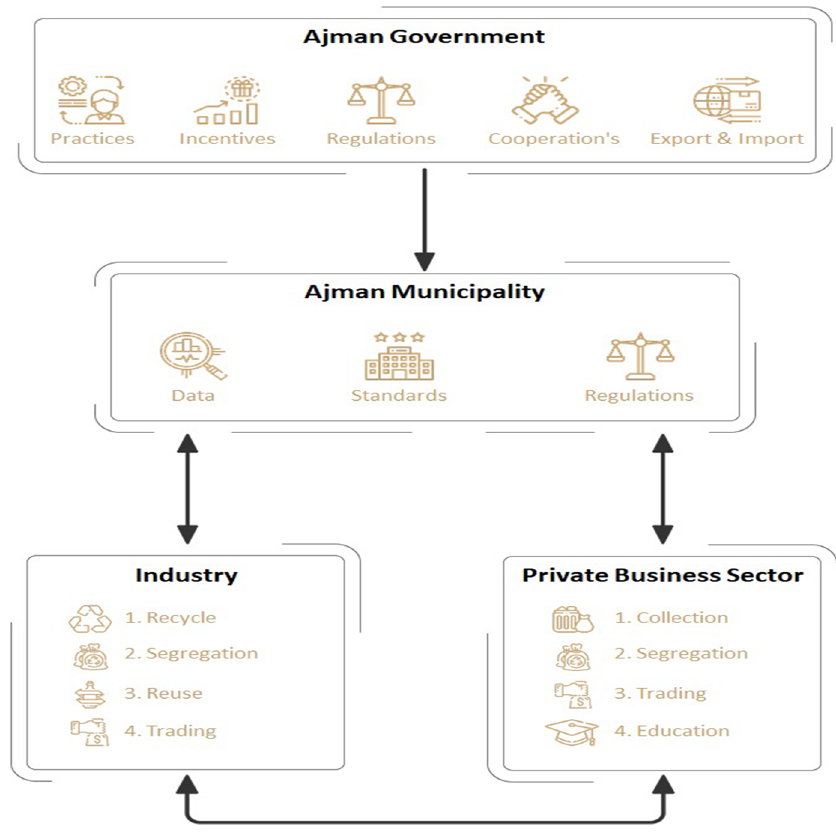
Fig. 13. Waste management sustainability model [Source: